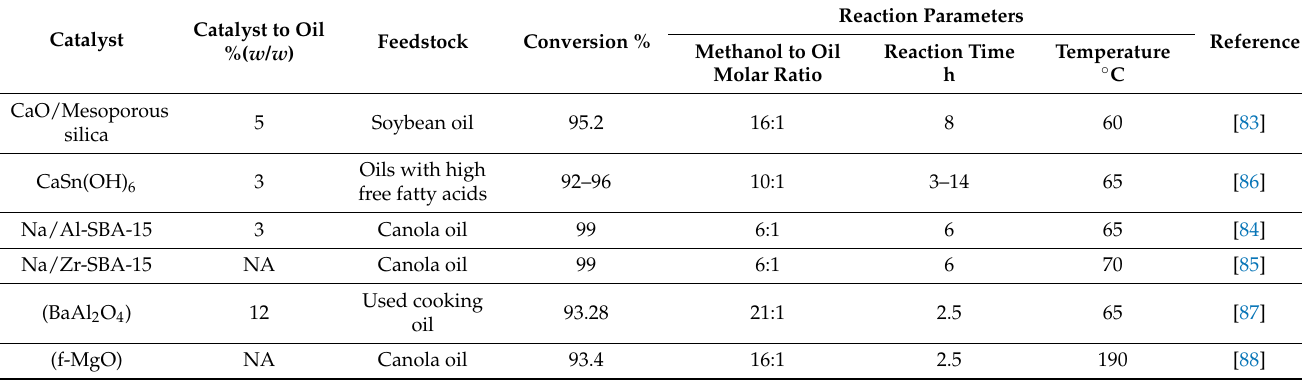
Table 2. Solid basic catalysts for biodiesel